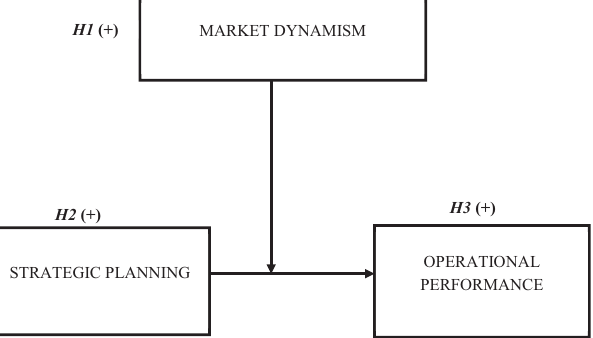
Figure 1. Conceptual model